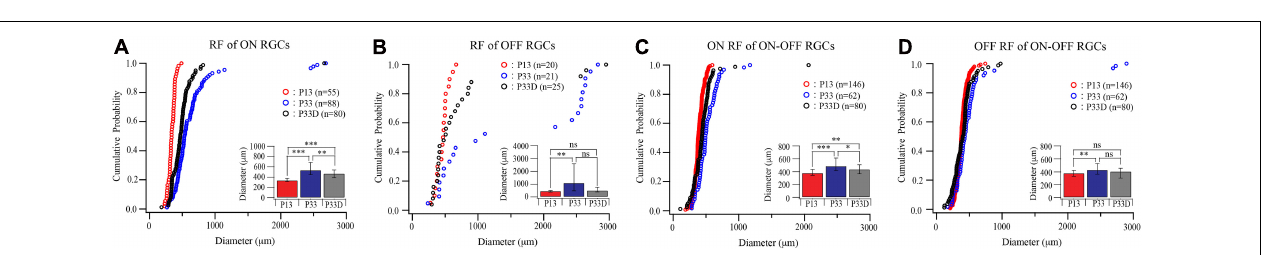
FIGURE 5 | Visual deprivation retards the developmental enlargement of receptive fields of RGCs. (A–D) Cumulative distribution curves and median diameters of receptive fields of P13 and P33 mice raised in cyclic light–dark condition and P33 mice raised in constant darkness (P33D) from birth for ON, OFF, and ON–OFF RGCs, respectively. Inset: median diameters of the receptive field. Error bars in the bar graphs indicate IQR. *0.05 > p > 0.01; ** 0.01 > p > 0.001; ***0.001 > p ; ns, not